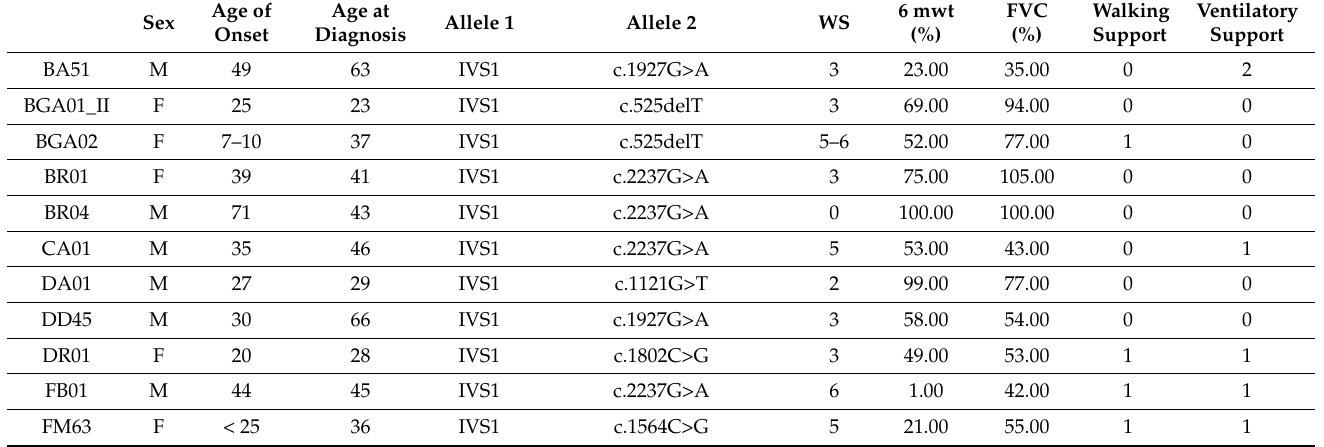
Table 1. Summary of demographic, genetic, and clinical data. Allele 1: IVS1 =